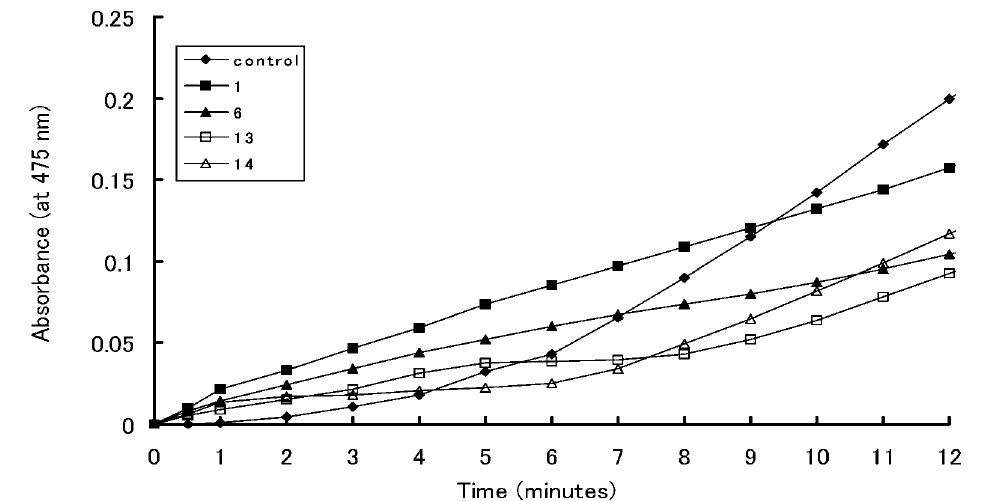
Figure 2. Lag period of L -dopaquinone formation. L -tyrosine (0.8 mM) was incubated with tyrosinase in the absence (control) or with the addition of baicalein ( 1 , 320 µ M), 6- hydroxyapigenin hydroxykaempferol ( 14 , 100 µ